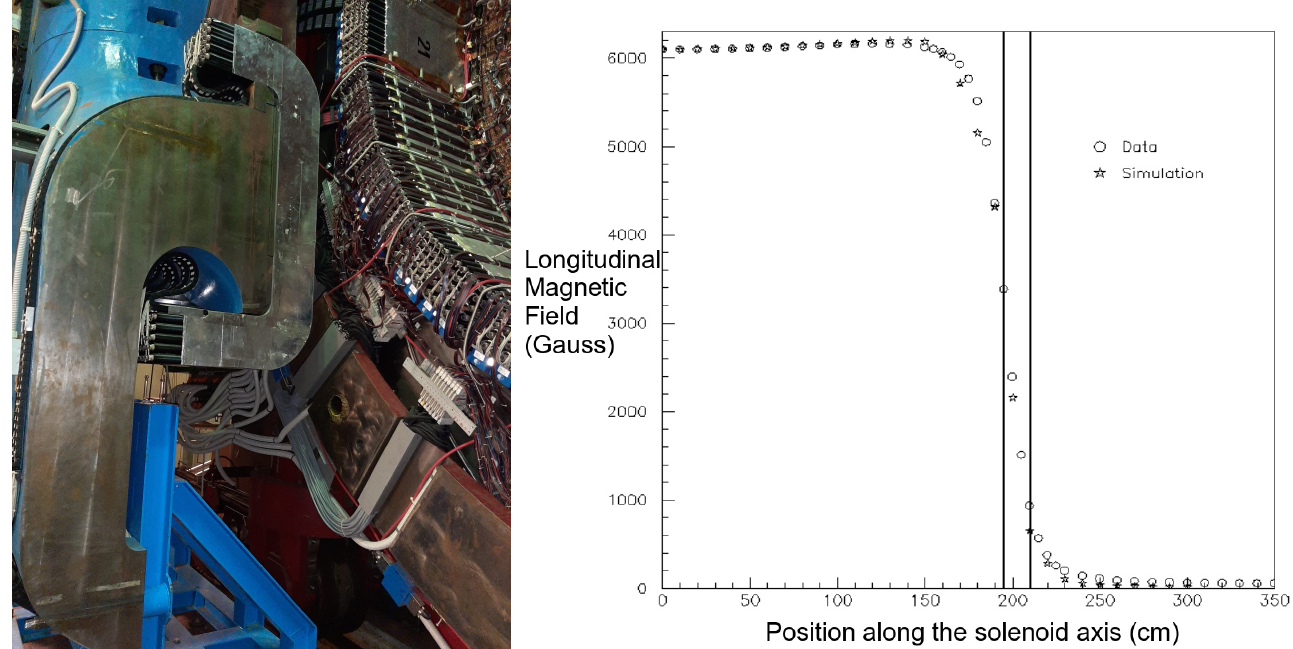
Figure 117. ( left ) A part of the KLOE magnet near one of the end caps. ( right ) The magnitude of the longitudinal (i.e., along the magnet symmetry axis) component of the magnetic field (in Gauss) as a function of the position along the magnet axis (in cm), measured from the center ( z = 0cm) toward the end cap ( z 200cm). Data and MC are compared. The field was ≈ measured and simulated on the magnet symmetry